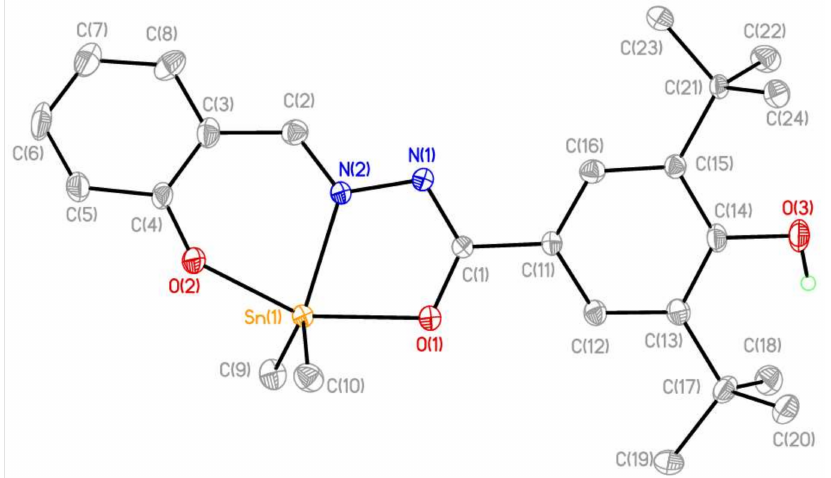
Figure 1. The general view of 2 in representation of atoms by thermal ellipsoids ( p =